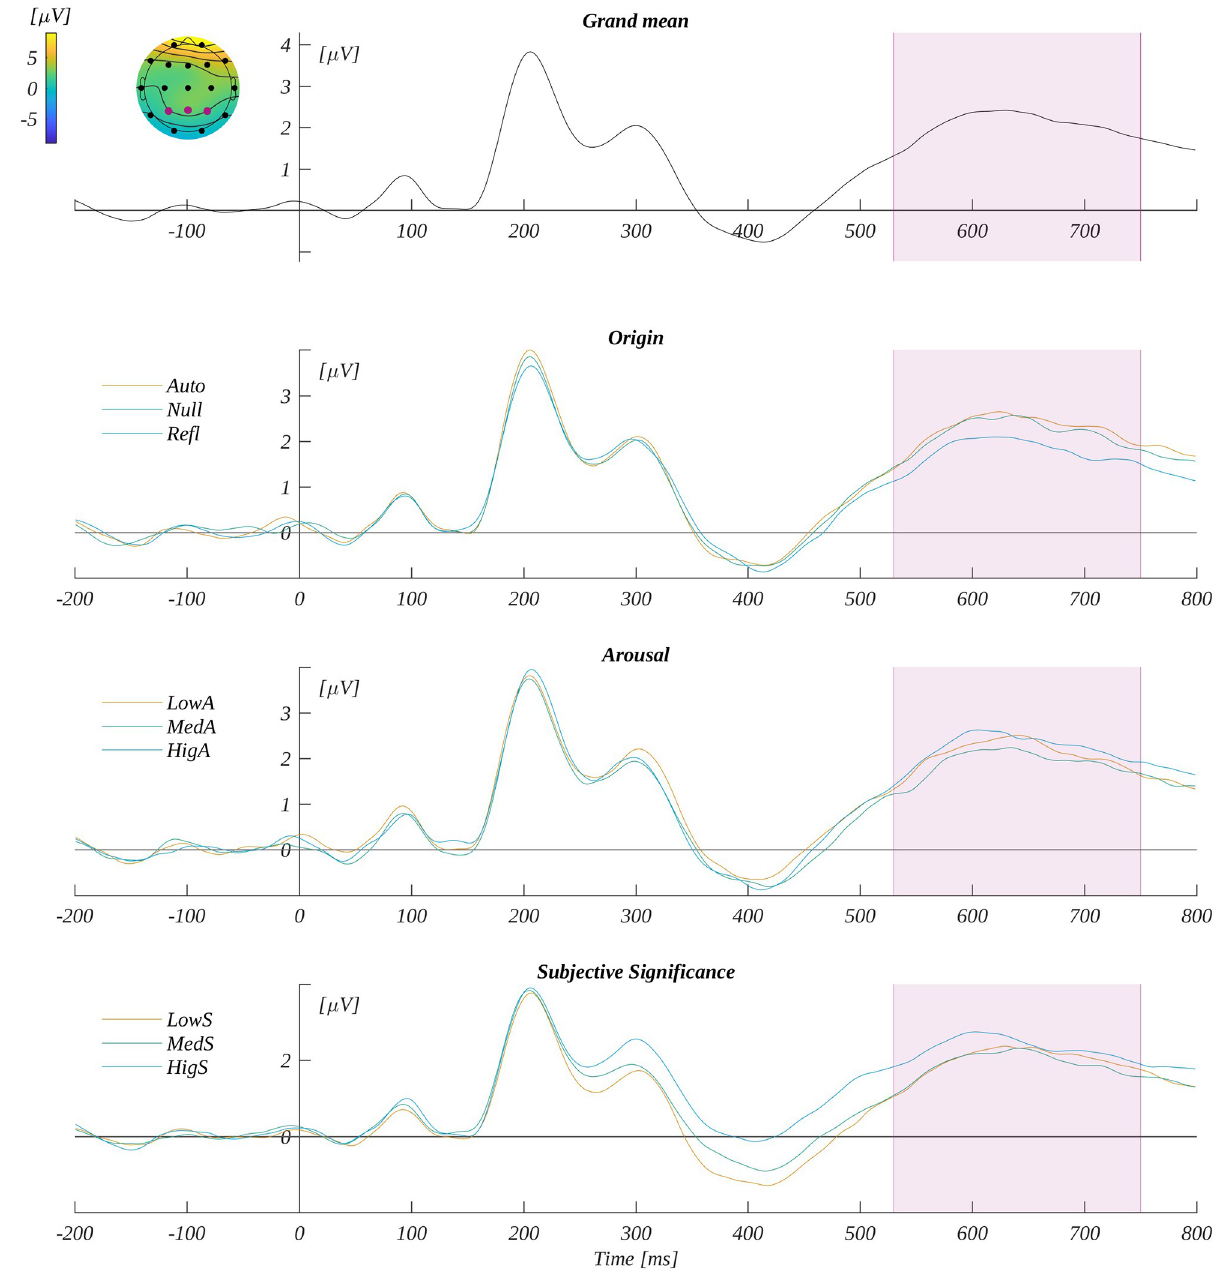
Fig 8. LPC potential. The upper plot: the grand average across electrodes from ROI LPC . The marked time-interval was selected for the LPC analysis. The insert shows the topography of the mean potential from this period with the electrodes forming the ROI LPC marked with pink dots. The three bottom plots are the time courses for ERP averaged across electrodes from ROI LPC for each level of origin, arousal and subjective